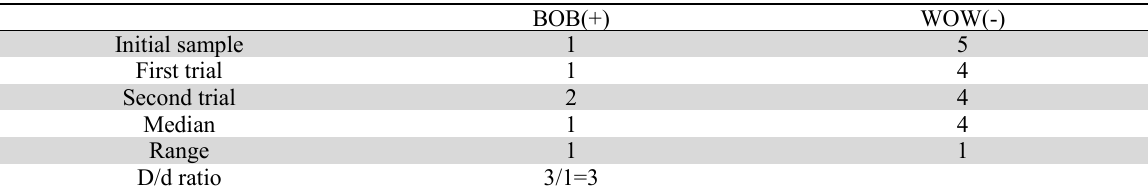
Calculation of D/d